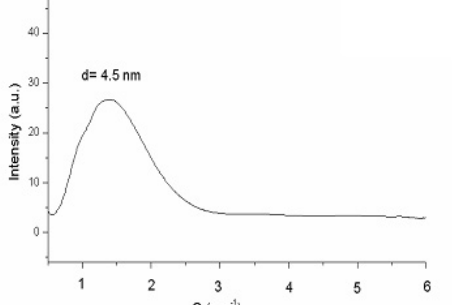
Figure 8. Small angle X-ray scattering (SAXS) curve at 20 °C of bicelles ( q = 2, 80% water content) 24 h after